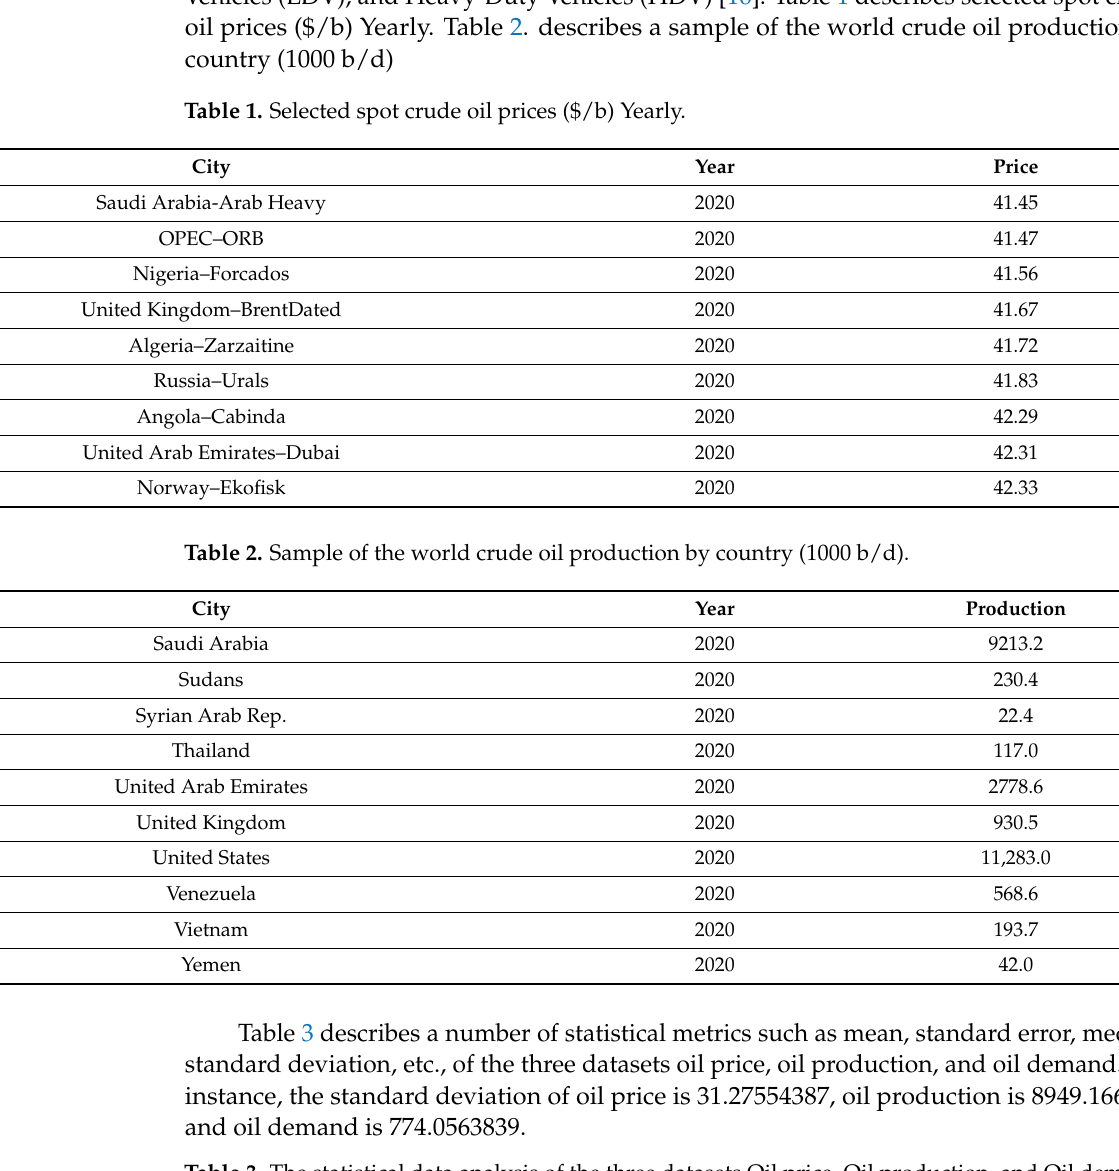
Table 3. The statistical data analysis of the three datasets Oil price, Oil production, and Oil demand.